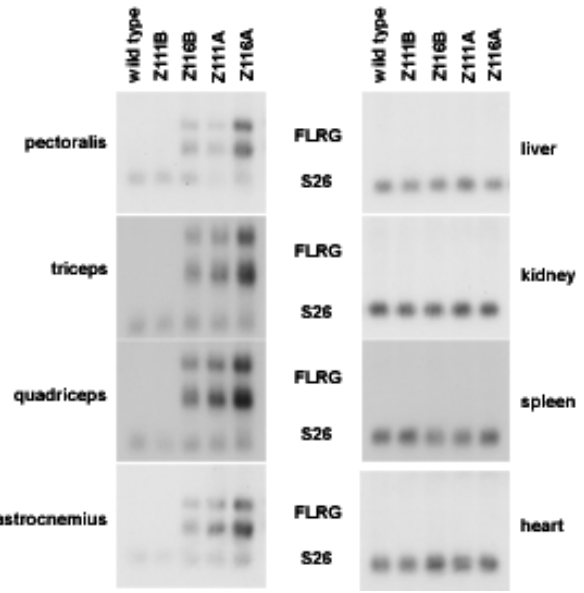
Figure 1. Northern analysis of FLRG transgenic mice. Total RNA was prepared from various tissues from 10-week old female mice, electrophoresed, blotted, and probed with a fragment derived from SV40 corresponding to the processing/polyadenylation sequences present in the transgenic construct. The blots were re-hybridized with a probe for the S26 ribosomal protein to control for loading.